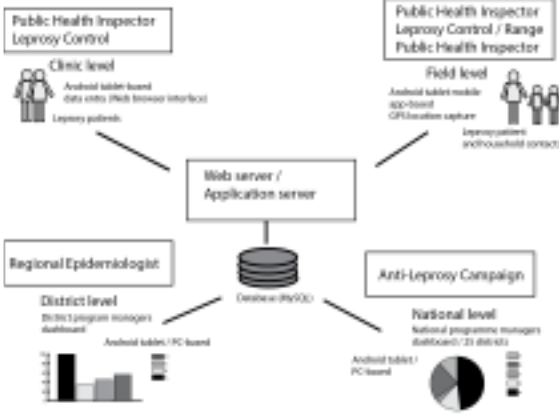
Figure 1. Software architecture diagram of the ALC